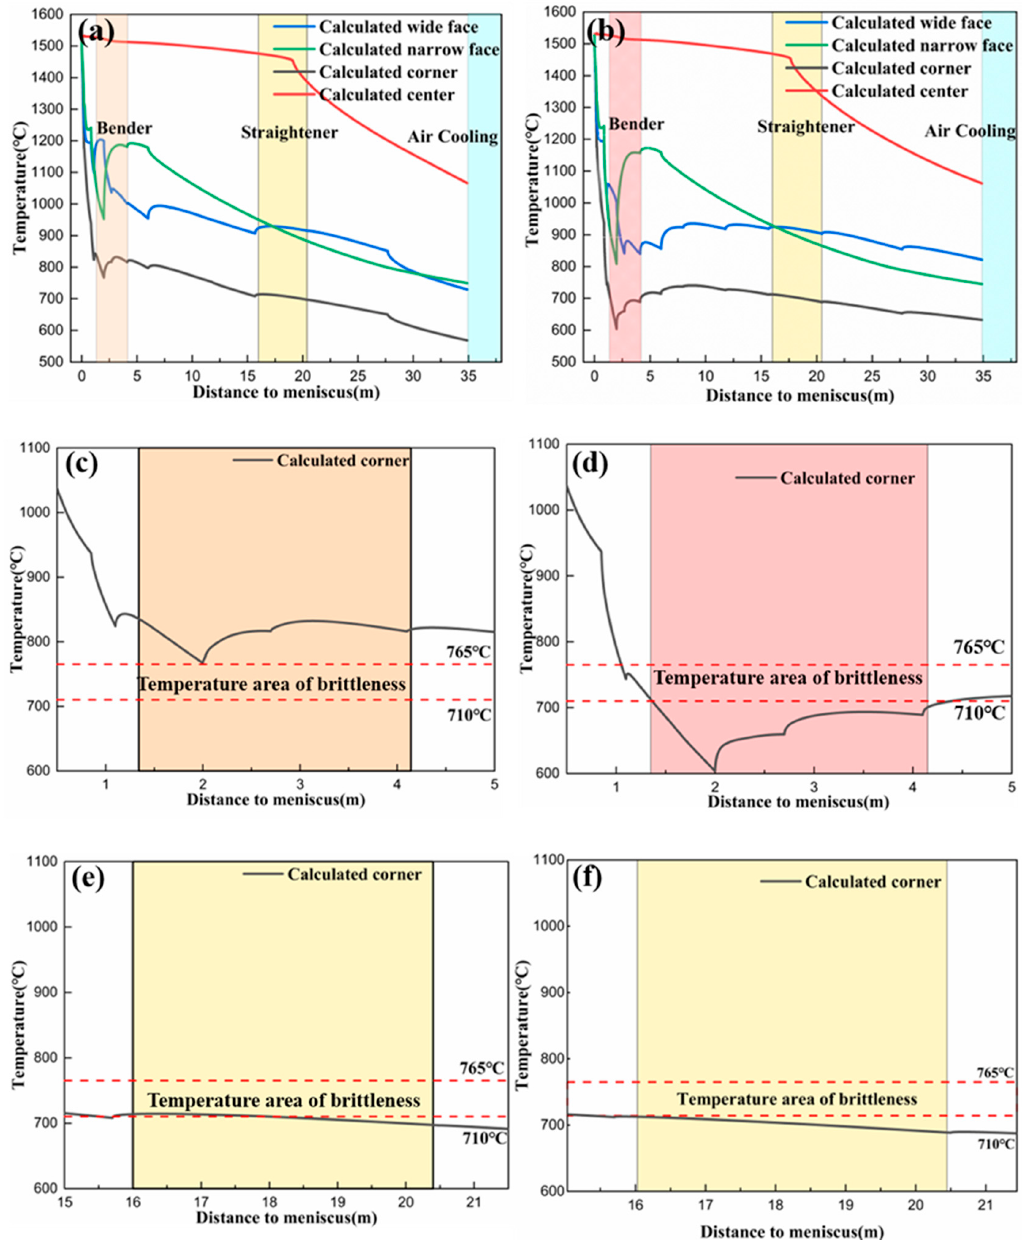
Figure 8. Continuous casting slab temperature curve under different water content conditions. ( a , c , e ) represent the temperature curves of the whole, bending section, and straightening section under weak cold conditions; and ( b , d , f ) represent the temperature of the whole, bending section, and straightening section under strong cold